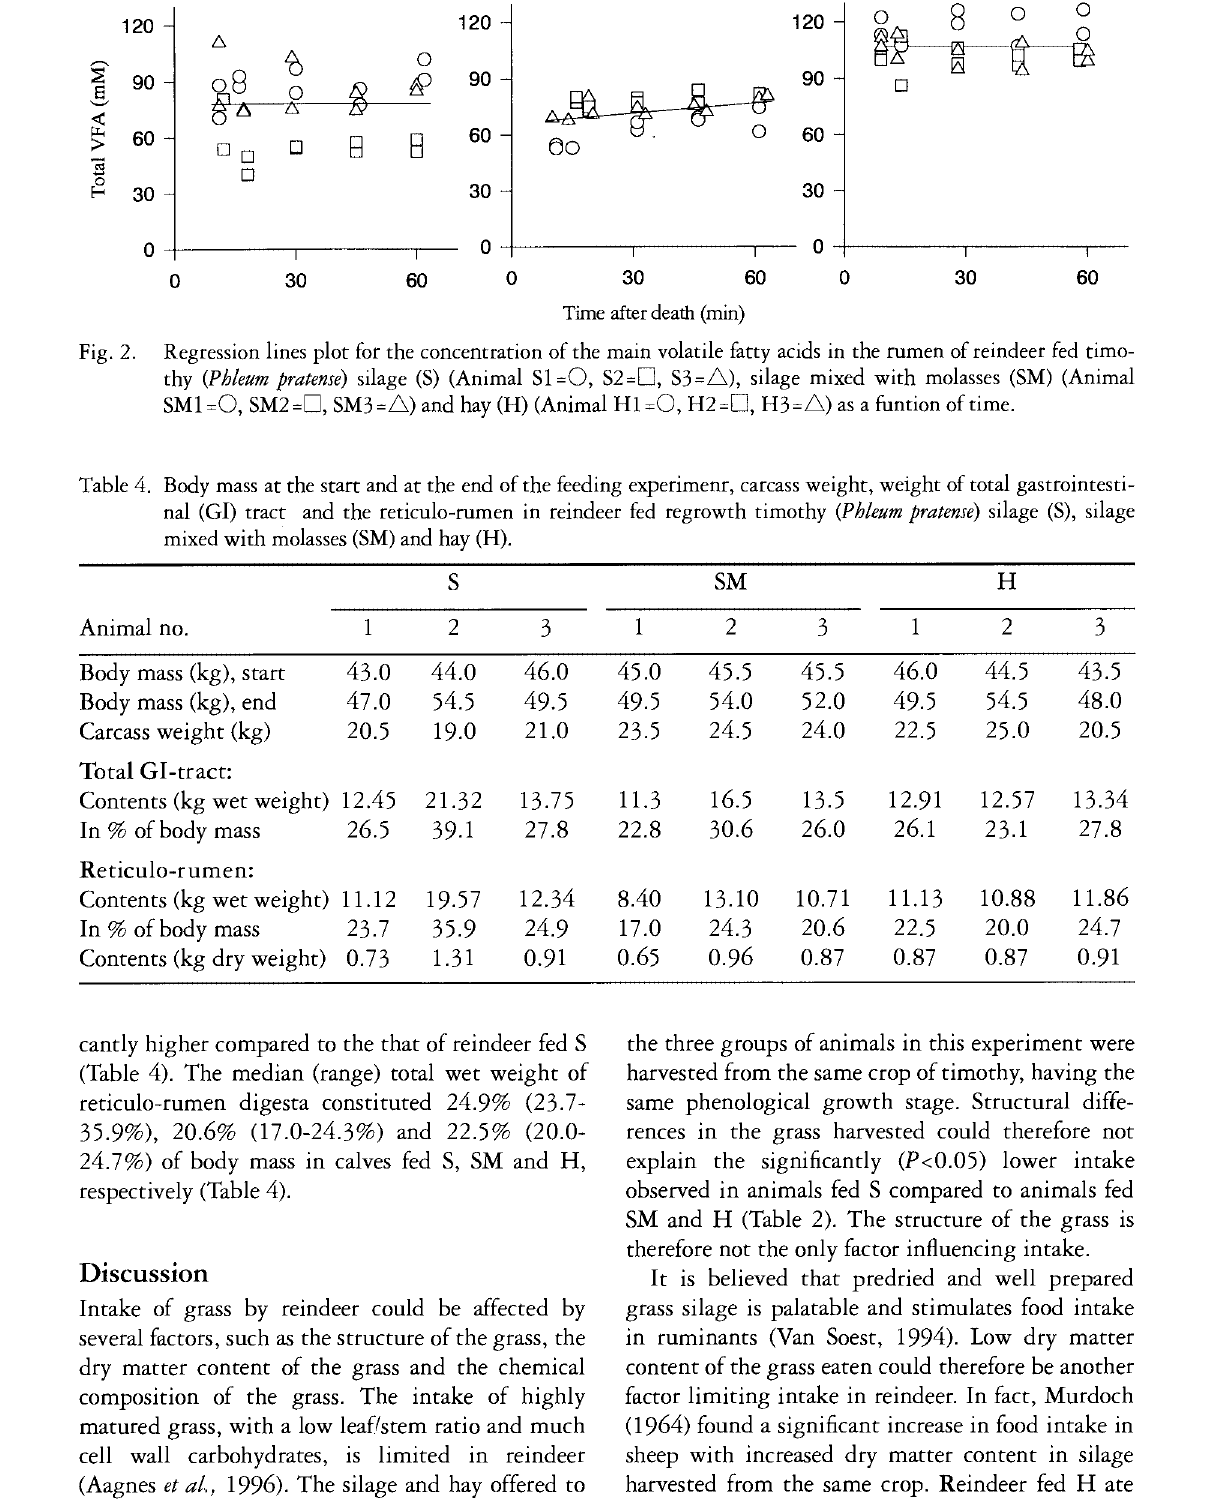
Fig. 2. Regression lines plot for the concentration of the main volatile fatty acids in the rumen of reindeer fed timo thy (Phleum pratense) silage (S) (Animal S1 =0, S2 =D, S3 =A), silage mixed with molasses (SM) (Animal